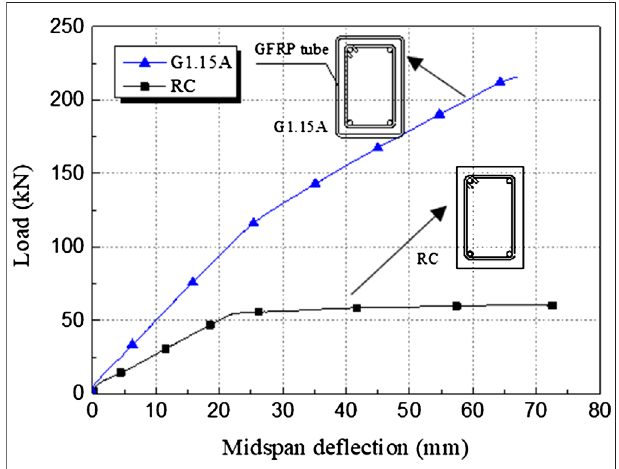
FIGURE 9 | Load-midspan de fl ection curves (specimen G1.15A and specimen RC).